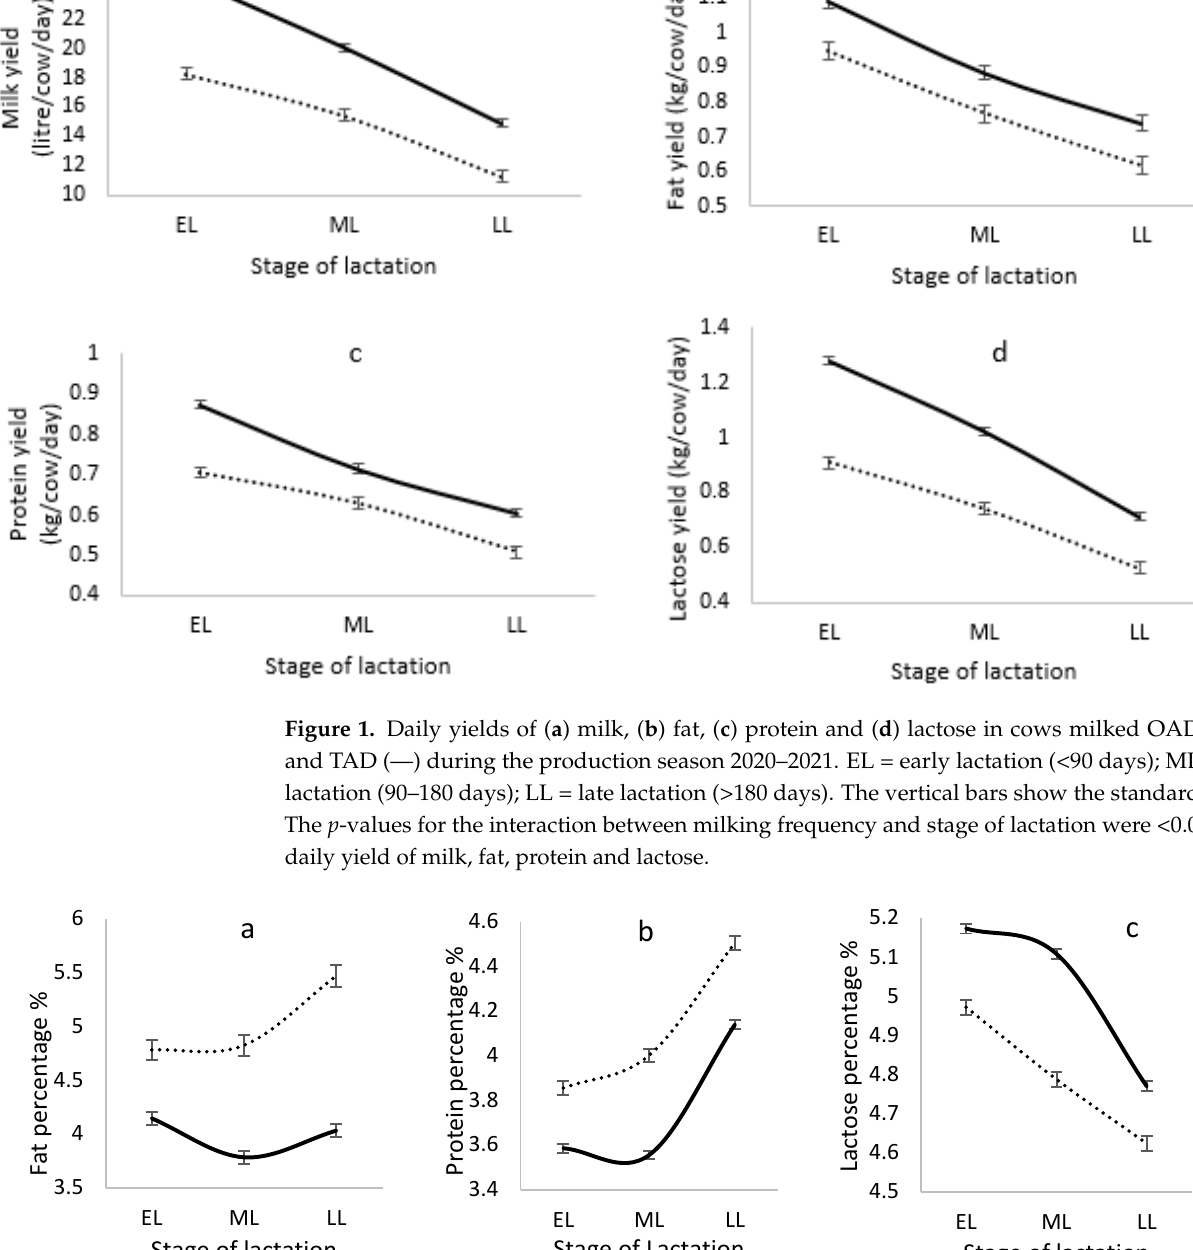
Figure 2. Percentage of ( a ) fat, ( b ) protein, and ( c ) lactose in cows milked OAD (….) and TAD (—) during the production season 2020–2021. EL = early lactation (<90 days); ML = mid lactation (90–180 days); LL = late lactation (>180 days). The vertical bars show the standard errors. The p -values for the interaction between milking frequency and stage of lactation were <0.0001 for fat, protein and lactose percentages.